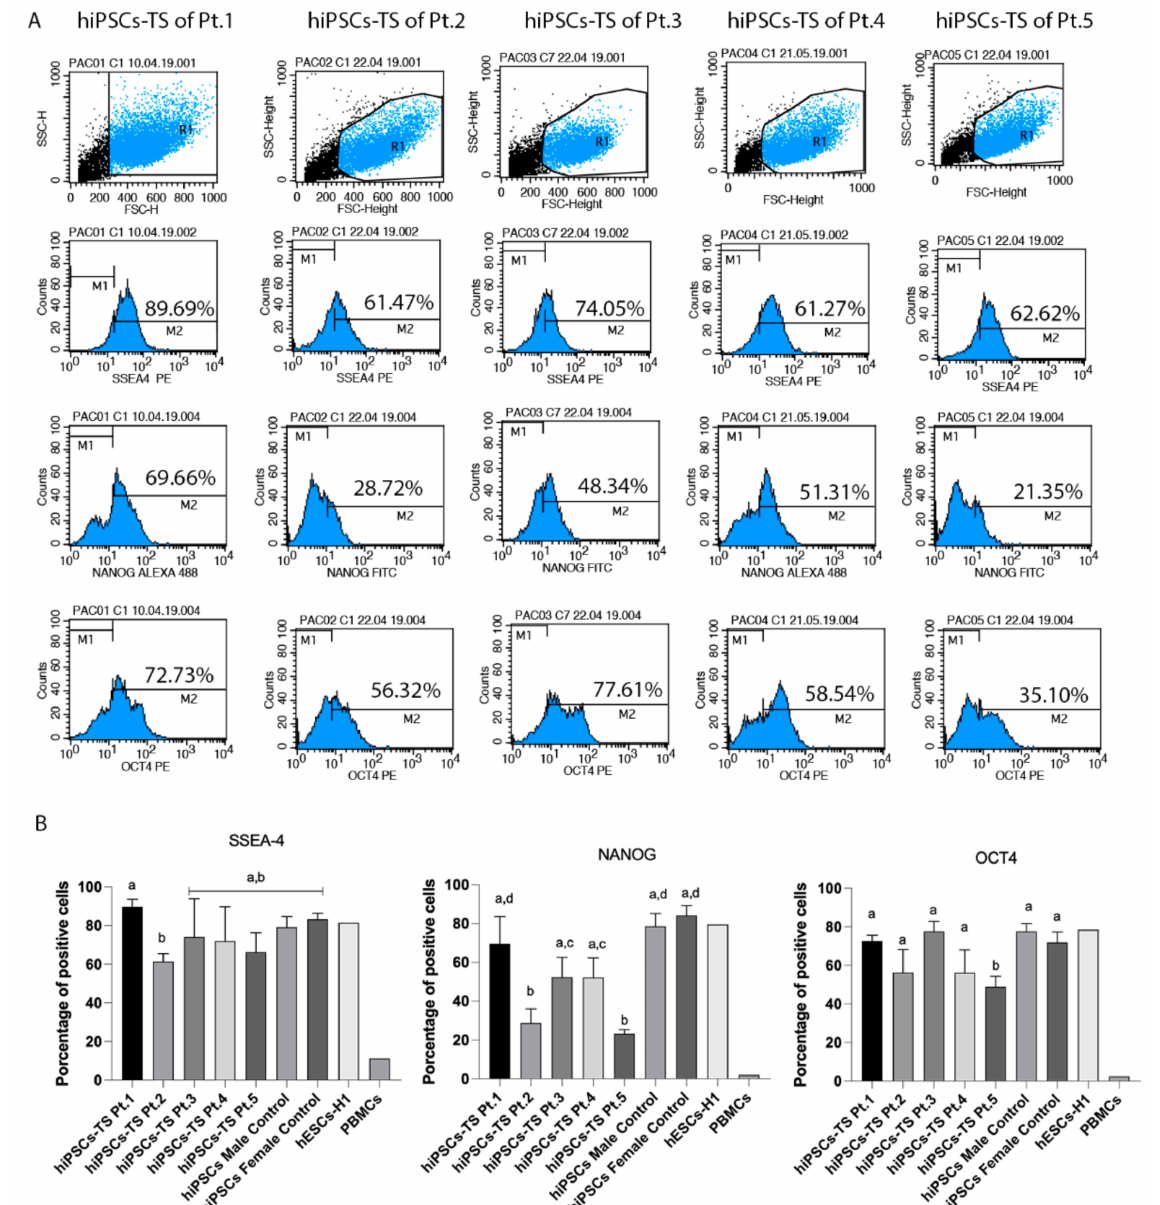
Figure 2. Flow cytometry analysis demonstrated the presence of pluripotent markers (SSEA-4, NANOG and OCT4) among all lines of hiPSCs-TS. ( A ) Histograms analysis showed in M2 the gate of positive cells present in each marker and cell line. ( B ) Percentage of positive cells in each line of hiPSCs-TS and hiPSCs controls lines. p values were calculated by Two-way ANOVA, followed by Tukey’s multiple comparisons test as appropriate (letters a-b-c-d show difference between groups). Error bars denote represent SEM. All flow cytometry analyses from hiPSCs-TS of Pt.1, Pt.2 and Pt.3 and control data were compiled from at least three biological and technical replicates. The data of hiPSCs-TS of Pt.4 and Pt.5 were compiled from three technical